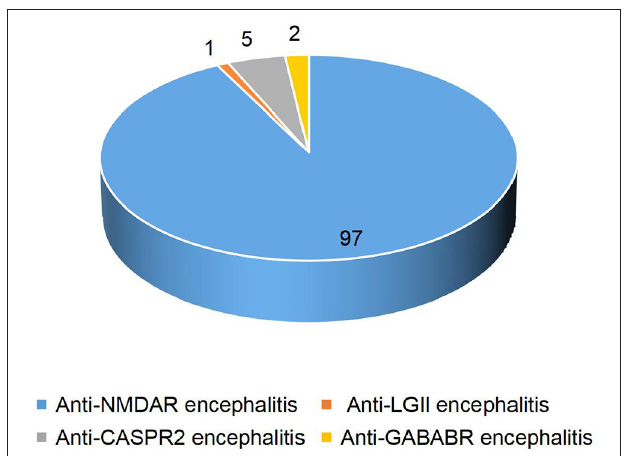
FIGURE 1 | Autoimmune encephalitis classification in